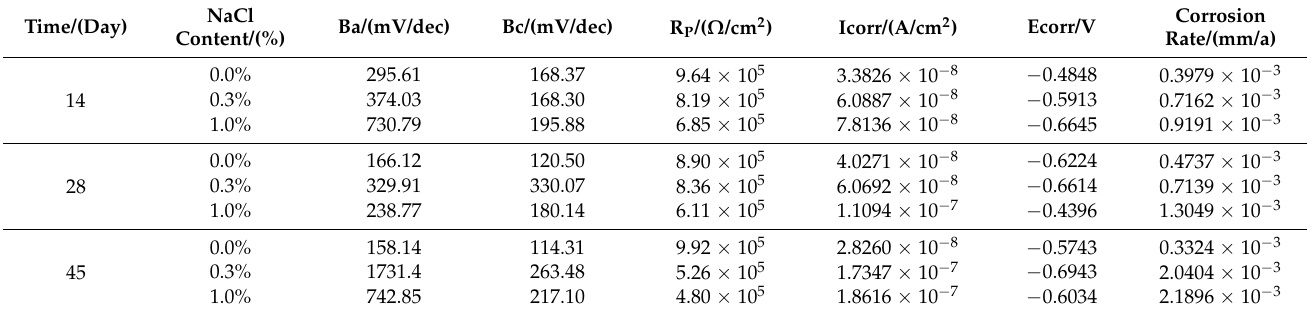
Figure 8. Polarization curve of X70 steel at 12 # height: ( a ) 14 days, ( b ) 28 days, and ( c ) 45 days. The top half of each polarization curve represented the anodic process of a corrosion cell, where an oxidation reaction took place. This oxidation reaction led to the metal dis- solving, and the dissolved metal entered the corrosion system as ions. The lower half of the polarization curves represented the cathodic process of the corrosion cell, where the reduction reaction occurred. This reduction reaction was mainly controlled by the diffu- sion of the dissolved oxygen limit [49]. After 14 days, significant passivation was visible in the anodic branch of the X70 steel polarization curve for the contaminated soil contain- ing 1.0% NaCl [50]. When this metal was passivated, the anode dissolution process no longer obeyed Fertal’s law, and the anode electrode dissolution rate decreased. This was probably due to the formation of an inner corrosion product film layer that prevented the